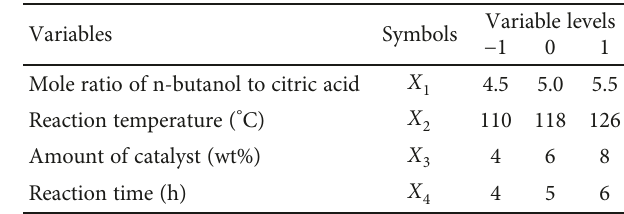
Table 1: Coded values of the variables used in the experimental design.